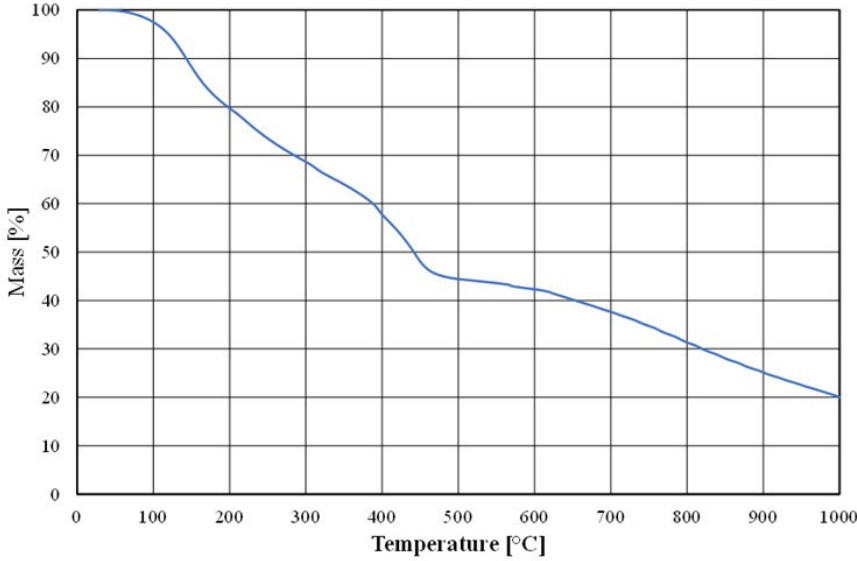
Figure 4. Thermogravimetric analysis of tested material (binder).